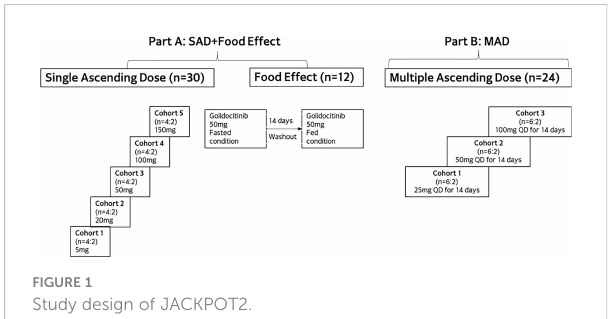
FIGURE 1 Study design of